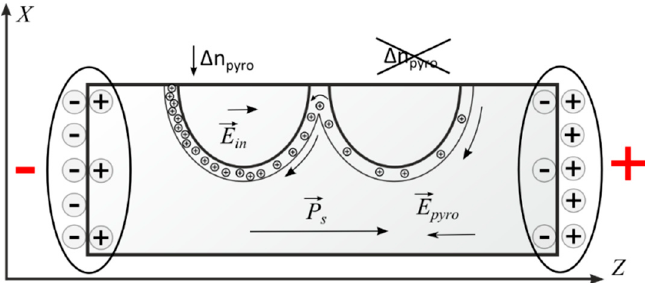
Figure 6. Charge flow under the influence of a pyroelectric field in the region of waveguides